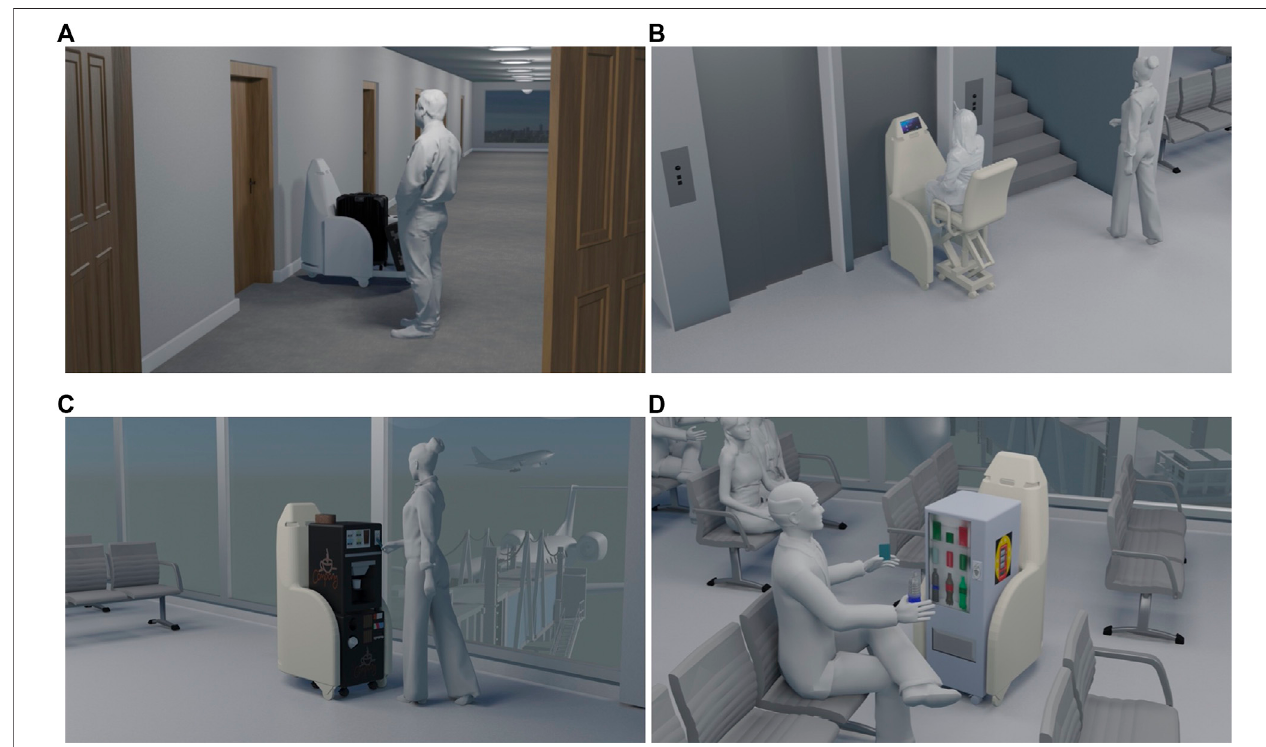
FIGURE 5 | SMOOTH-robot solving four different tasks in various environments using four different modules: (A) baggage delivery in a hotel; (B) transport of humans in a hospital; (C) delivery of coffee; and (D) delivery of beverages in an airport.